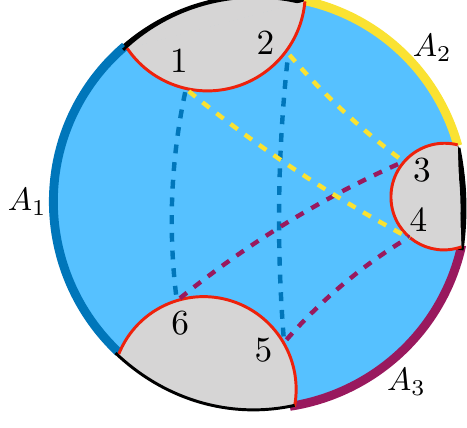
Figure 23 . An allowed surface con(cid:12)guration after the integer